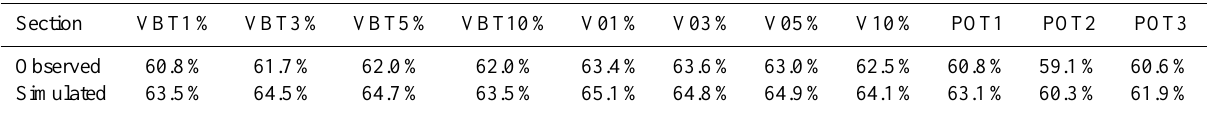
Table 2. Average PAMF of each classification technique for modeled and observed streamflow where stations have different PMs. Section Observed